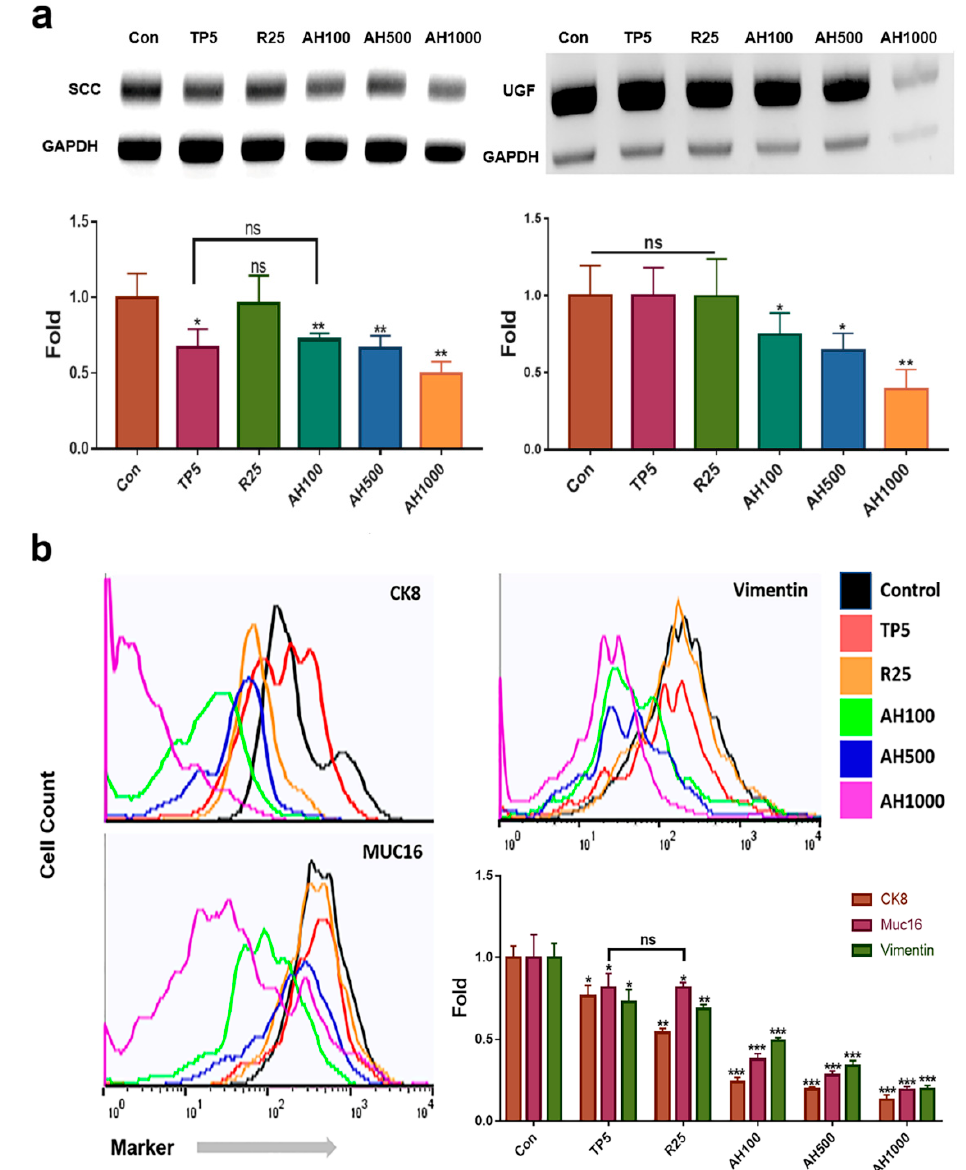
Figure 1. Levels of endometrial cancer (EC) cell markers in the presence of bioactive substances. ( a ) qPCR results indicate that the expression levels of markers of the endometrial cancer cells, such as squamous cell carcinoma antigen (SCC) and urinary gonadotropin fragment (UGF), exposed to bioactive substances, including 5 µg/mL tocopherol- α (TP5), 25 µg/mL rutin (R25), and 100, 500, and 1000 µg/mL A. helianthus extract (AH100, AH500, and AH1000, respectively), were downregulated. ( b ) CK8 + , Muc16 + and Vimentin + cells were counted using a flow cytometer. ns: not significant; * p < 0.05; ** p < 0.01; *** p < 0.001.